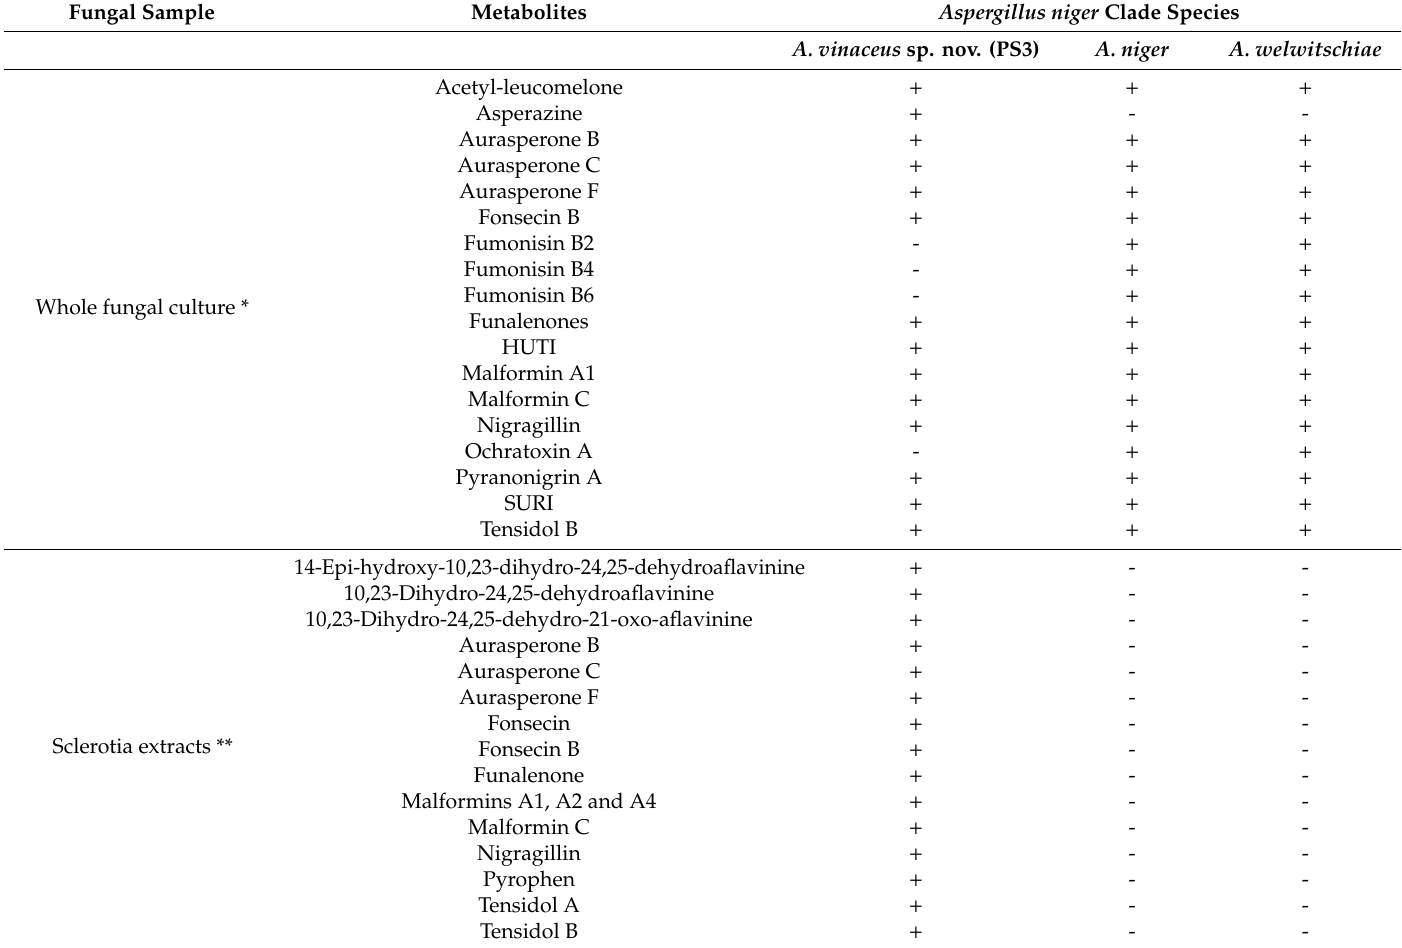
Table 3. Principal secondary metabolites produced by Aspergillus niger clade